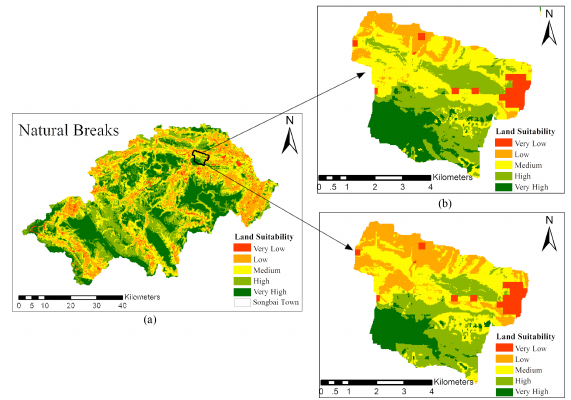
Figure 4. Two land suitability maps of Songbai Town.